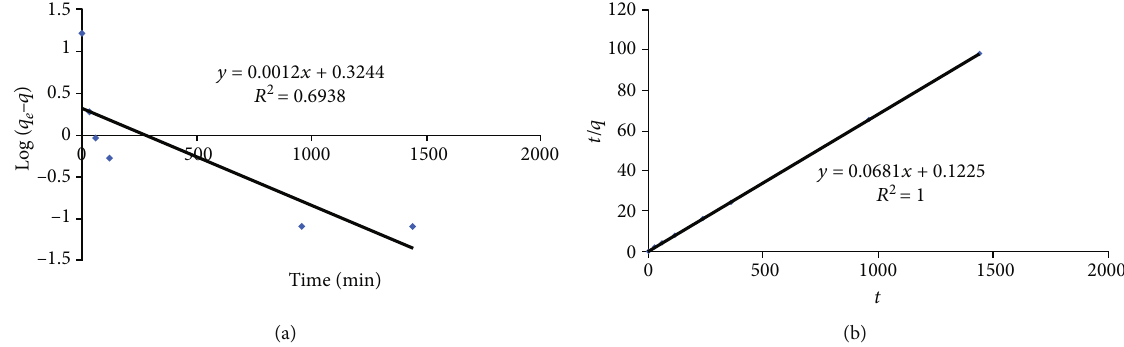
y = 0.0012 x + 0.3244 R 2 = 0.6938